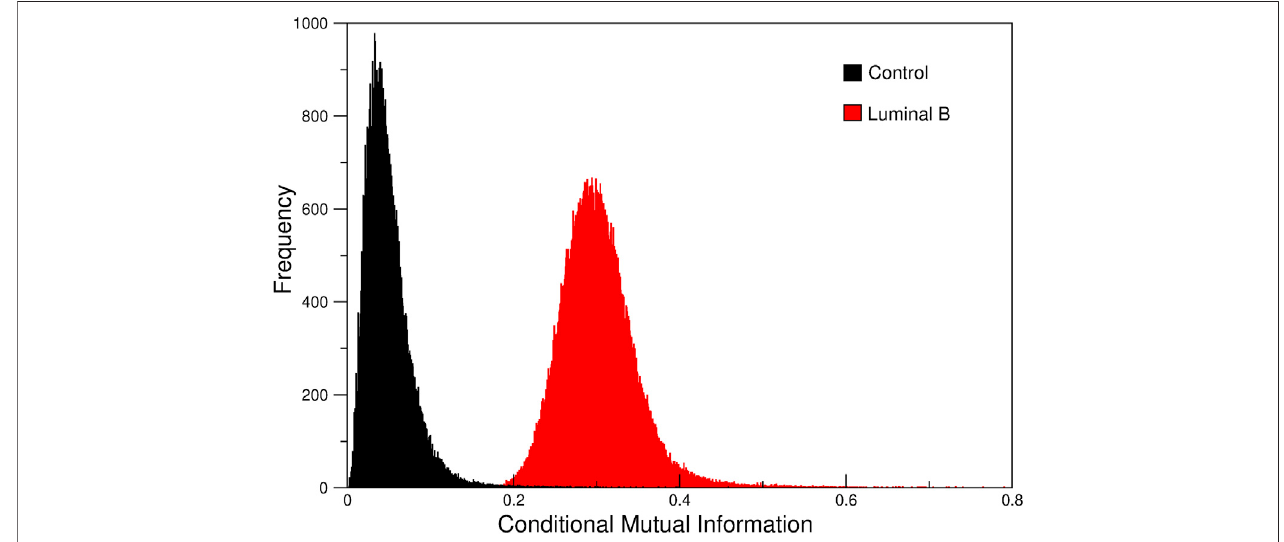
FIGURE3| ConditionalMutualInformationfornormaladjacenttissue(black)andLuminalBtumors(red).WecannoticethatLuminalBtumorspresentdistinctively higher values of CMI than Controls.